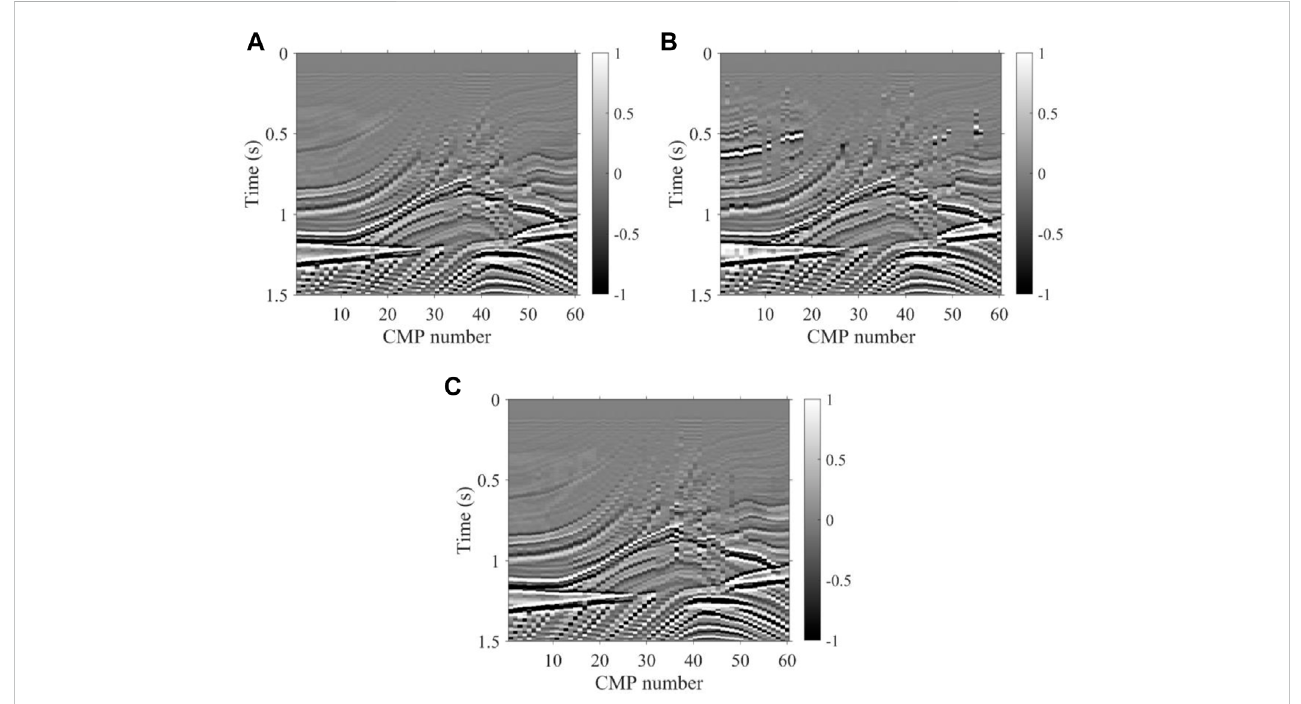
FIGURE 8 Stacking pro fi les of synthetic data without noise. (A) True velocity, (B) velocity of K-means, and (C) velocity of the method